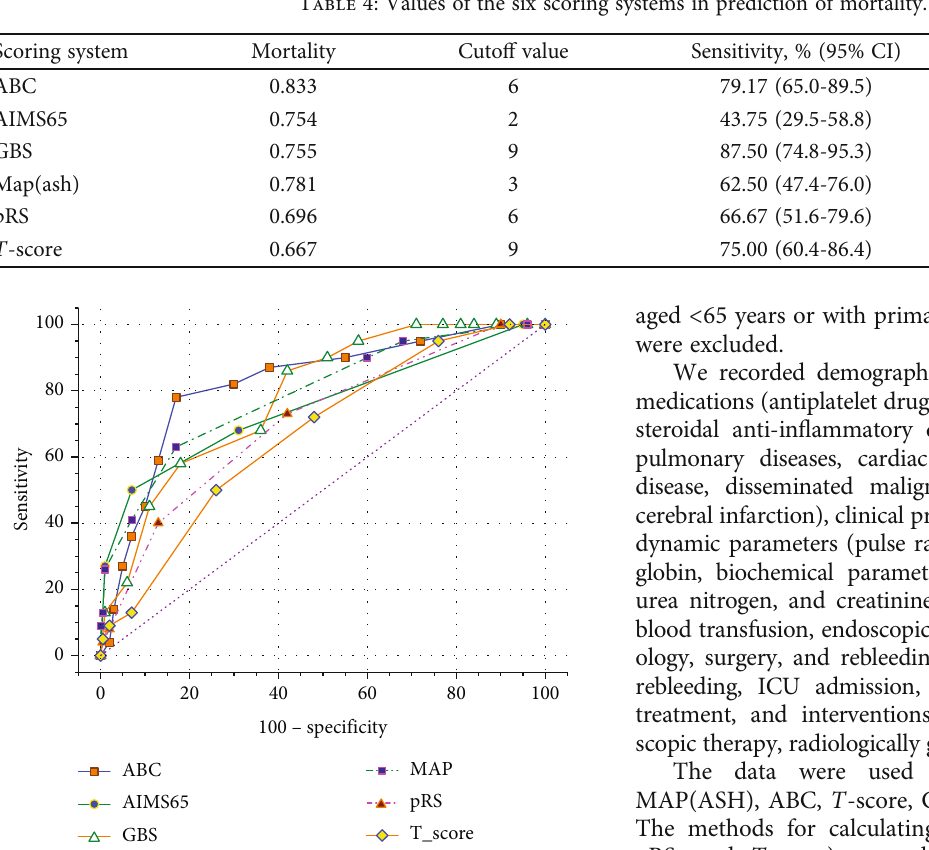
Table 4: Values of the six scoring systems in prediction of mortality.